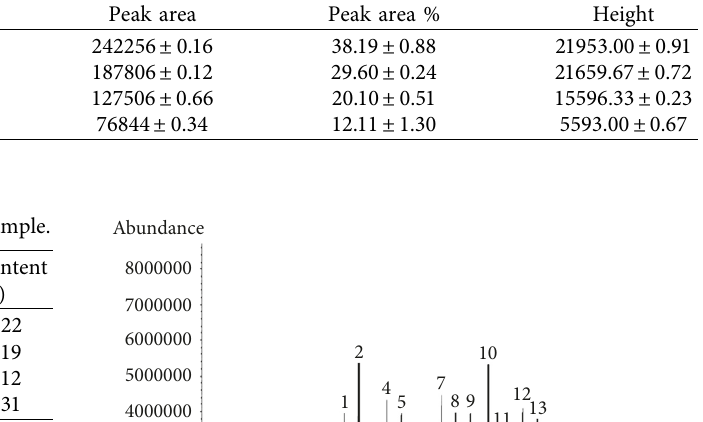
Figure 3: HPLC-UV chromatogram for the B. vulgaris L peels and pomaces sample with UV detector at 538nm. Table 3: Chromatographic peak tables for the plant extract.